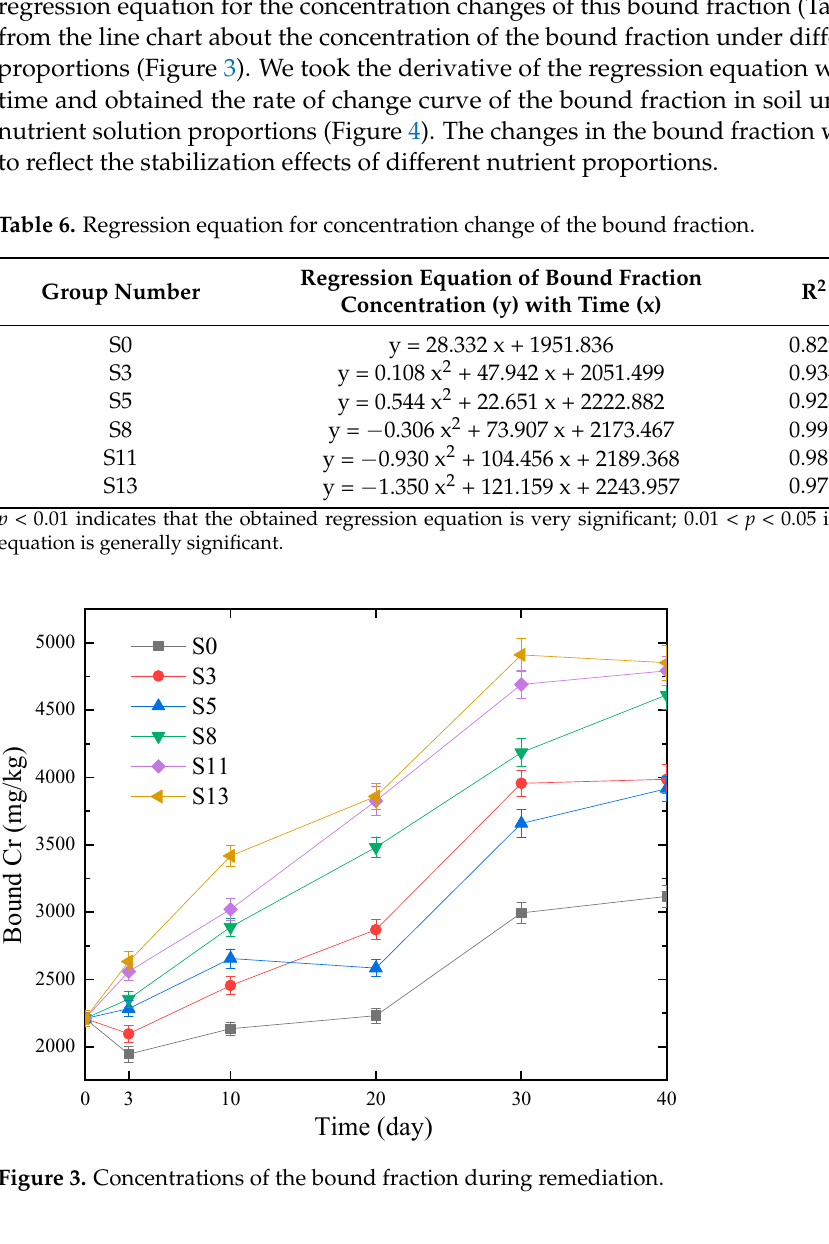
Table 5. Linear regression analysis among fractions.